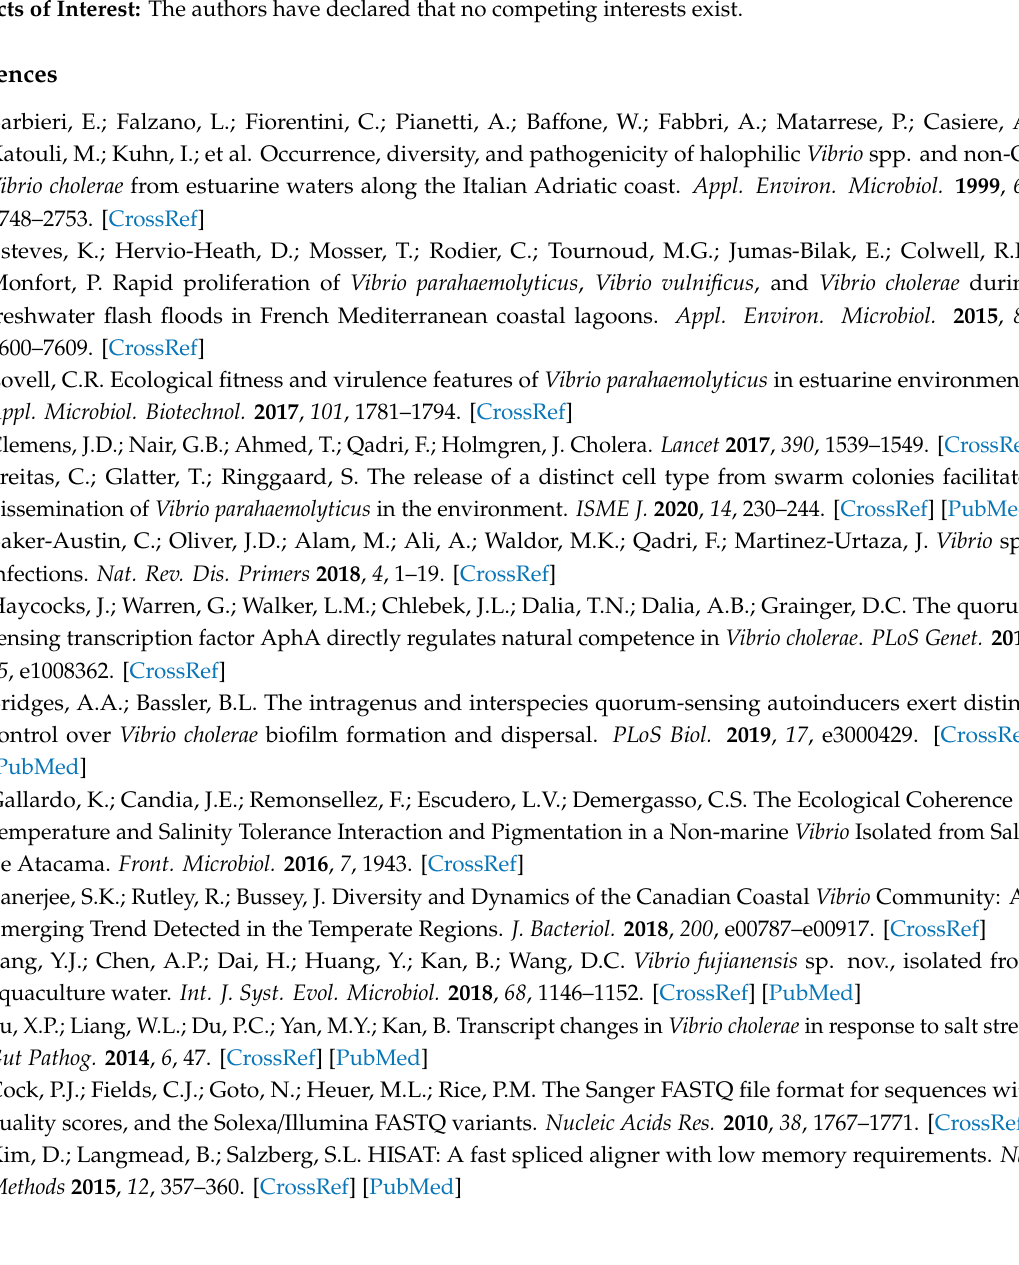
Figure S1: Sequence length distribution of V. fujianensis transcripts analyzed in this study. Figure S2: Di ff erentially expressed genes (DEGs) cluster analysis of gene expression patterns between the high-salt and low-salt condition. Figure S3: ( A ) Functional classification of gene ontology (GO) annotations of the up-regulated di ff erentially expressed genes (DEGs). ( B ) Functional classification of GO annotations of the down-regulated DEGs. ( C ) Bubble charts of GO enrichment analysis of the up-regulated DEGs. ( D ) Bubble charts of GO enrichment analysis of the down-regulated DEGs. Figure S4: Functional classification of KEGG pathway of di ff erentially expressed genes (DEGs). Table S1: Overview of 16S rRNA gene sequences of Vibrio species analyzed in this study. Table S2: Genomic overview of Vibrio species analyzed in this study. Table S3: Virulence-associated factors profile of V. fujianensis and other pathogenic Vibrio